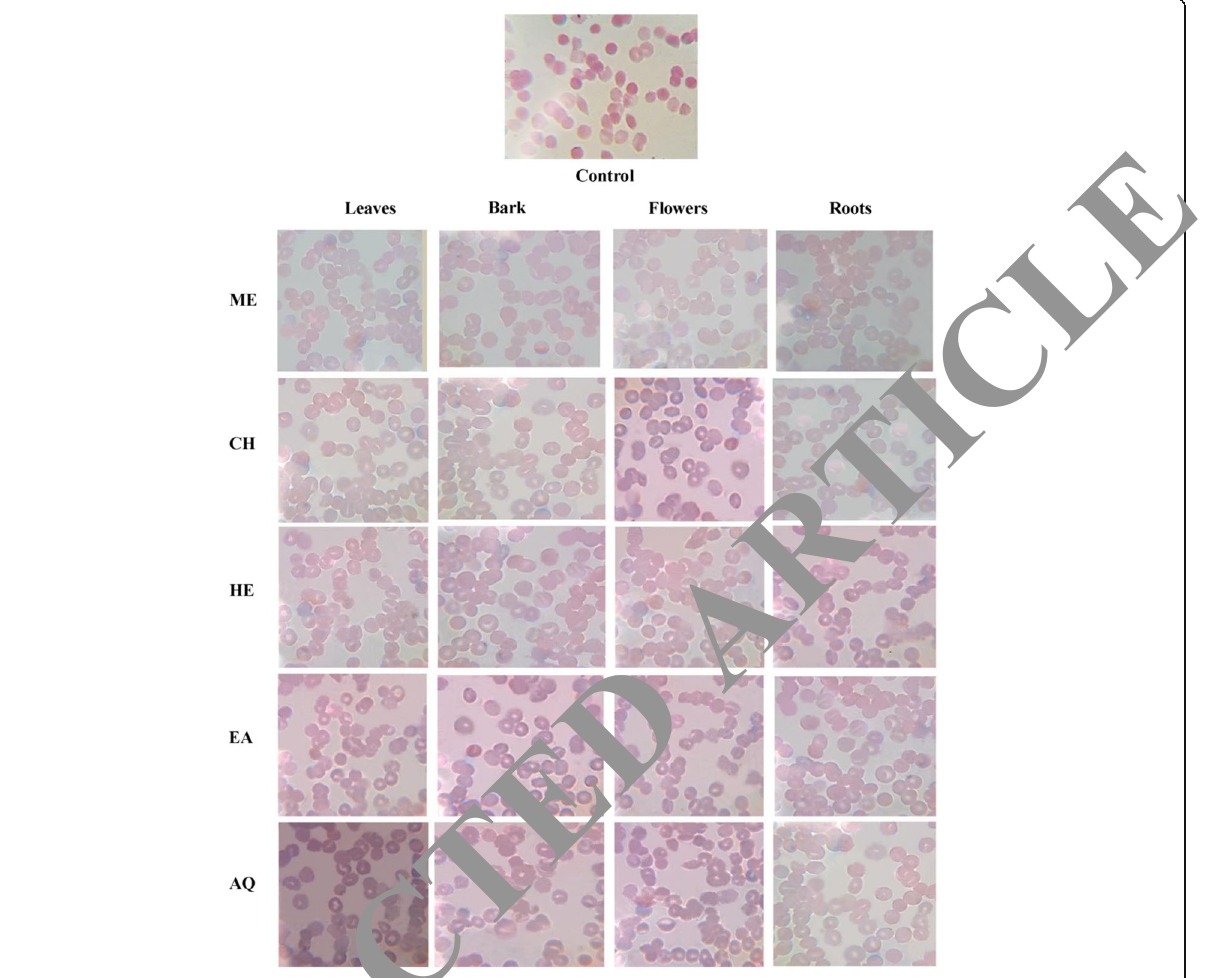
Fig. 5 Screening for chemical injury to erythrocytes after treatment of different crude extracts from Pongamia pinnata at higher concentration of 200 μ g/mL (ME- methanol, CH- chloroform, HE- hexane, EA- ethyl acetate, AQ-